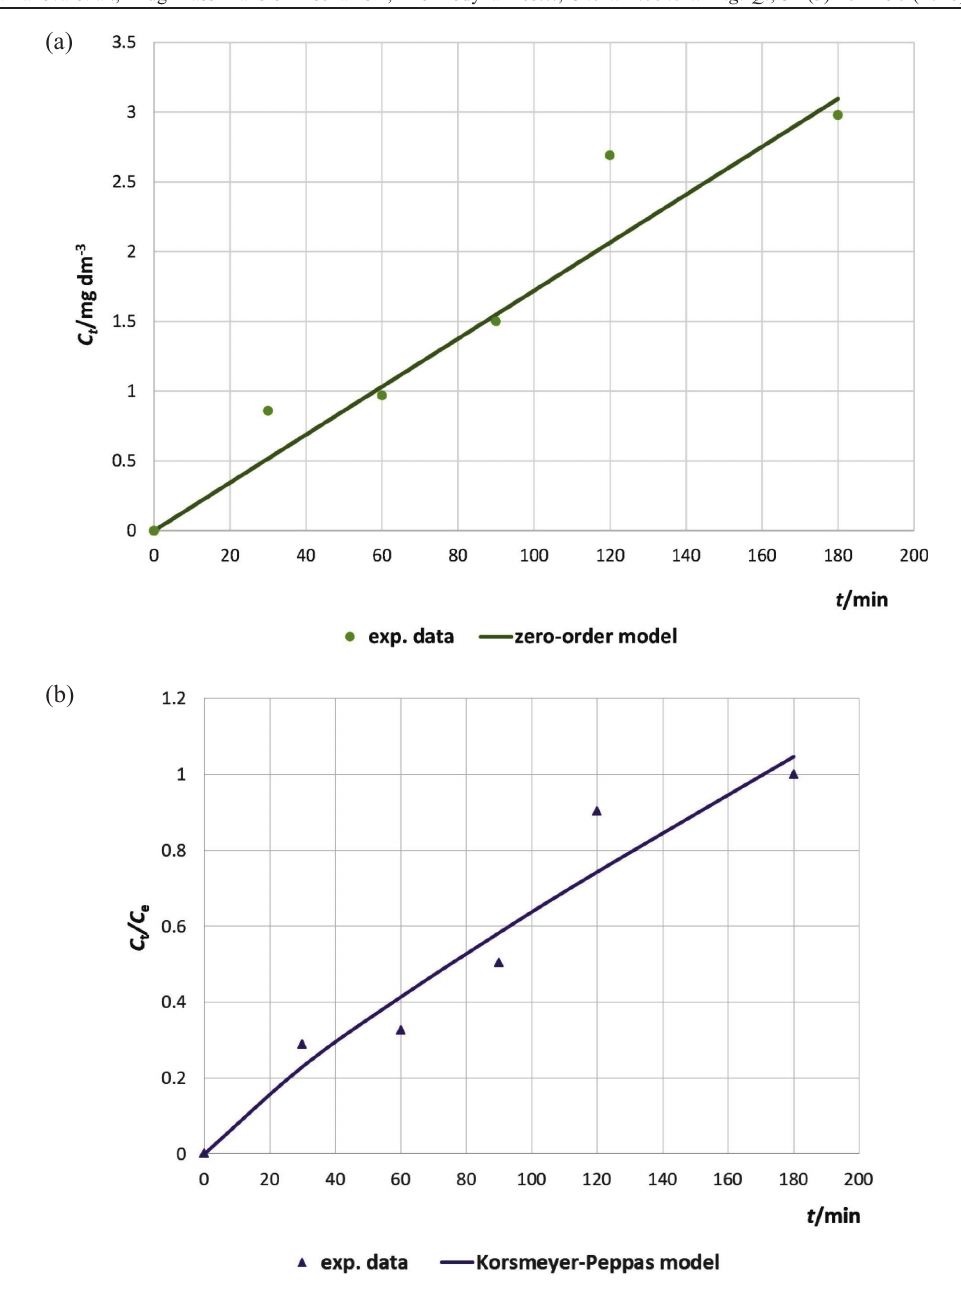
Fig. 9 – Applicability of: a) the zero-order model, and b) Korsmeyer-Peppas model to the experimental data for vitamin E release from